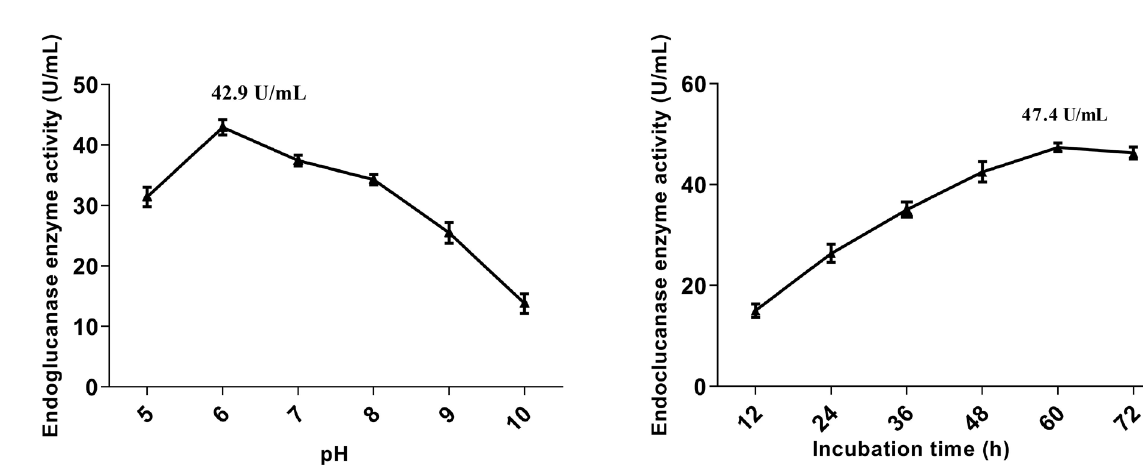
Figure 7. The effect of initial pH on the endoglucanase enzyme activity. Culture condions: MPP concentration 50 g/L, 2 g/L yeast extract, Temperature 40°C, and incubation time 48